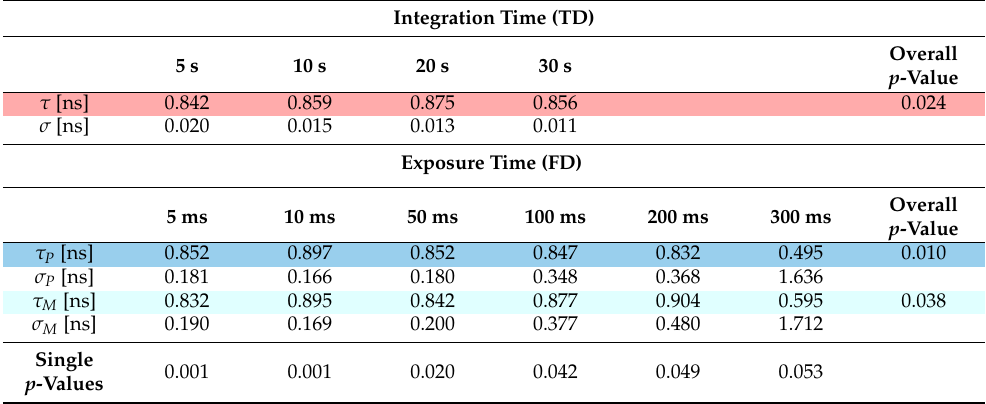
Table 2. Single and overall p -values for each exposure time for the phase- and demodulation-lifetime of the FD setup, as well as the exposure time of the TD setup for measurements on rose